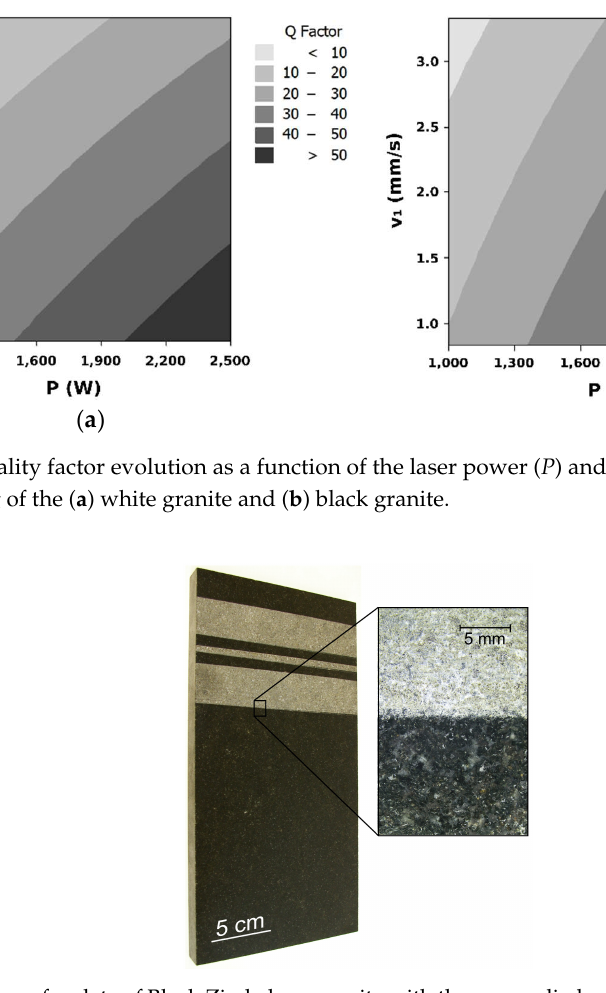
Figure 11. Image of a plate of Black Zimbabwe granite with three non-slip bands made by laser blasting and a detail of the transition from polished to laser treated surface.